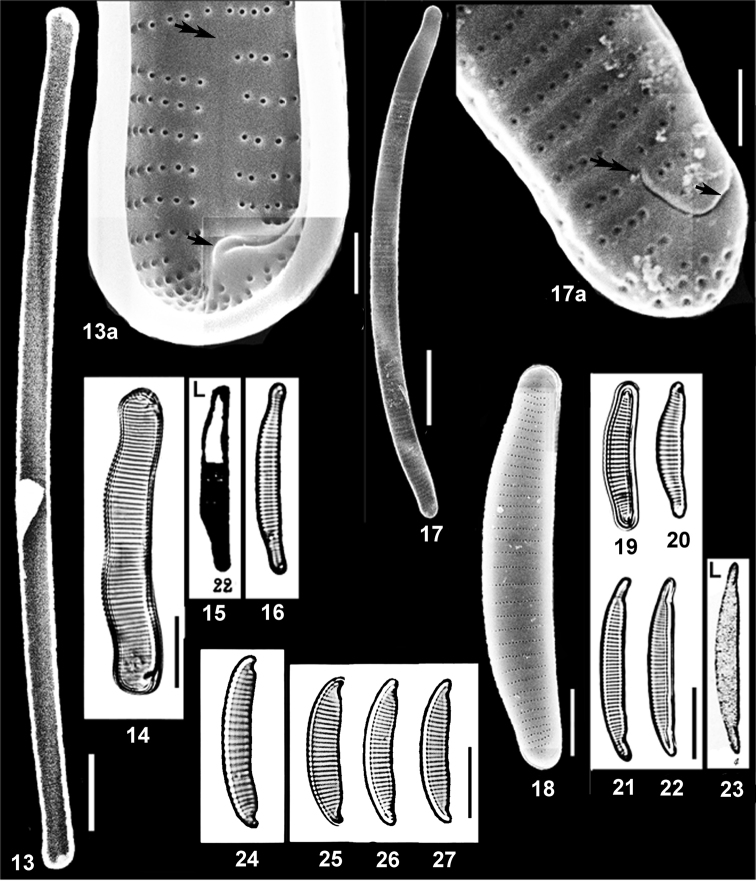
New and rare in Ukraine species of Eunotia Ehrenb. from Ukrainian Polissya and the Lectotypes of two Eunotia species. 13, 13aEunotiapseudoflexuosa Hust., arrow indicates rimoportula at the middle of pole where raphe slit distal end finishes on the outer valve surface, double arrow – position of terminal fissure distal end on the outer valve surface, between the arrows – hyaline field from inside valve surface where the terminal fissure is located on the outer valve surface 14Eunotiaruzickae Bílý & Marvan 15, 16Eunotiaimplicata Nörpel-Schempp et al. Lectotype: 15 = Eunotiaimpressavar.angusta Grunow in Van Heurck 1881: pl. 33/fig. 22, designated here 17, 17aEunotia sp. 2 (cf.mongolica Kulikovskiy et al.) 18–20Eunotia sp. 3 (cf. Eunotiapaludosa Grunow) 21–23Eunotiaincisa W. Smith ex Gregory. Lectotype: 23 = Eunotiaincisa W. Smith ex Gregory 1854: pl. 4/fig. 4, designated here 24Eunotia sp. 4 (cf. Eunotiaintermedia (Krasske ex Hustedt) Nörpel & Lange-Bert.) 25–27Eunotia sp. 5 (cf. Eunotiameridiana Metzeltin & Lange-Bert.). Figs 13, 17, 18 SEM: 13, 13a inside valve surface 17, 17a, 18 outside valve surface; 19–28 LM. Scale bars: 10 µm (13–17, 19–27); 5 µm (18); 1 µm (13a, 17a).